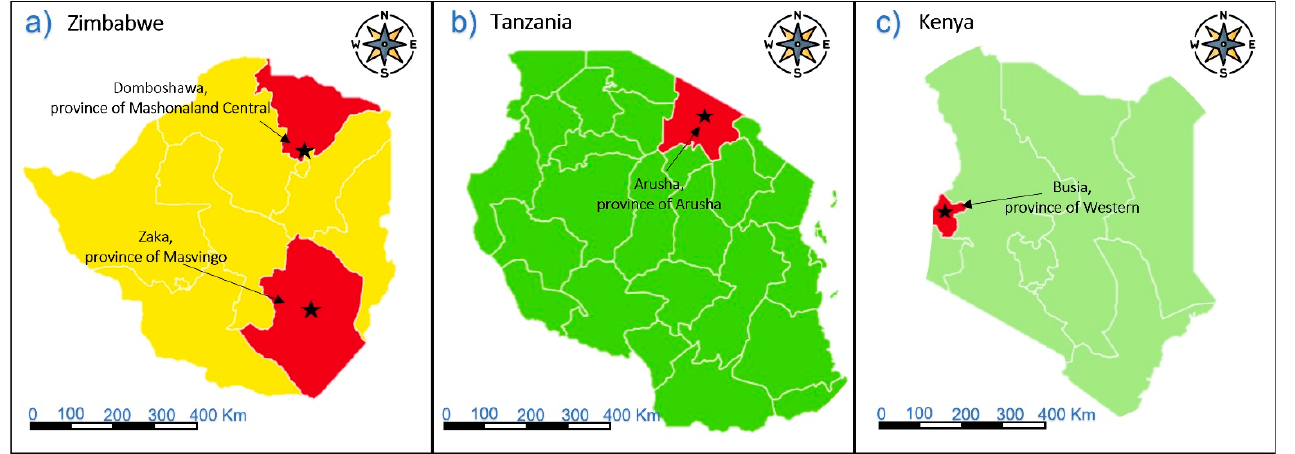
Figure 2. ( a ) Map of Zimbabwe, in red provinces of Mashonaland Central and Masvingo; ( b ) map of Tanzania, in the red province of Arusha; ( c ) map of Kenya, in the red Western province. Asterisks mark the locations where we took the data.